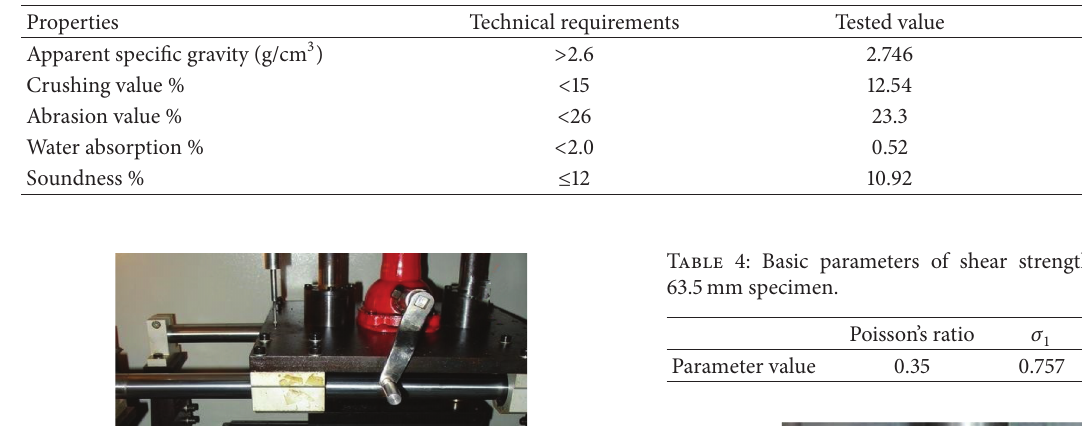
Table 3: Technical properties of coarse aggregates.